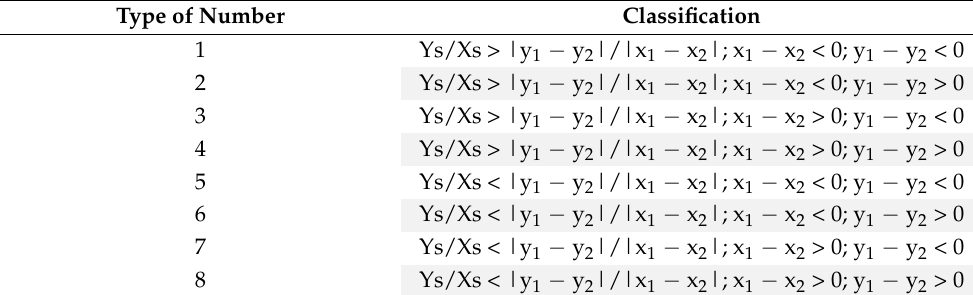
Table 1. The different types of L AB